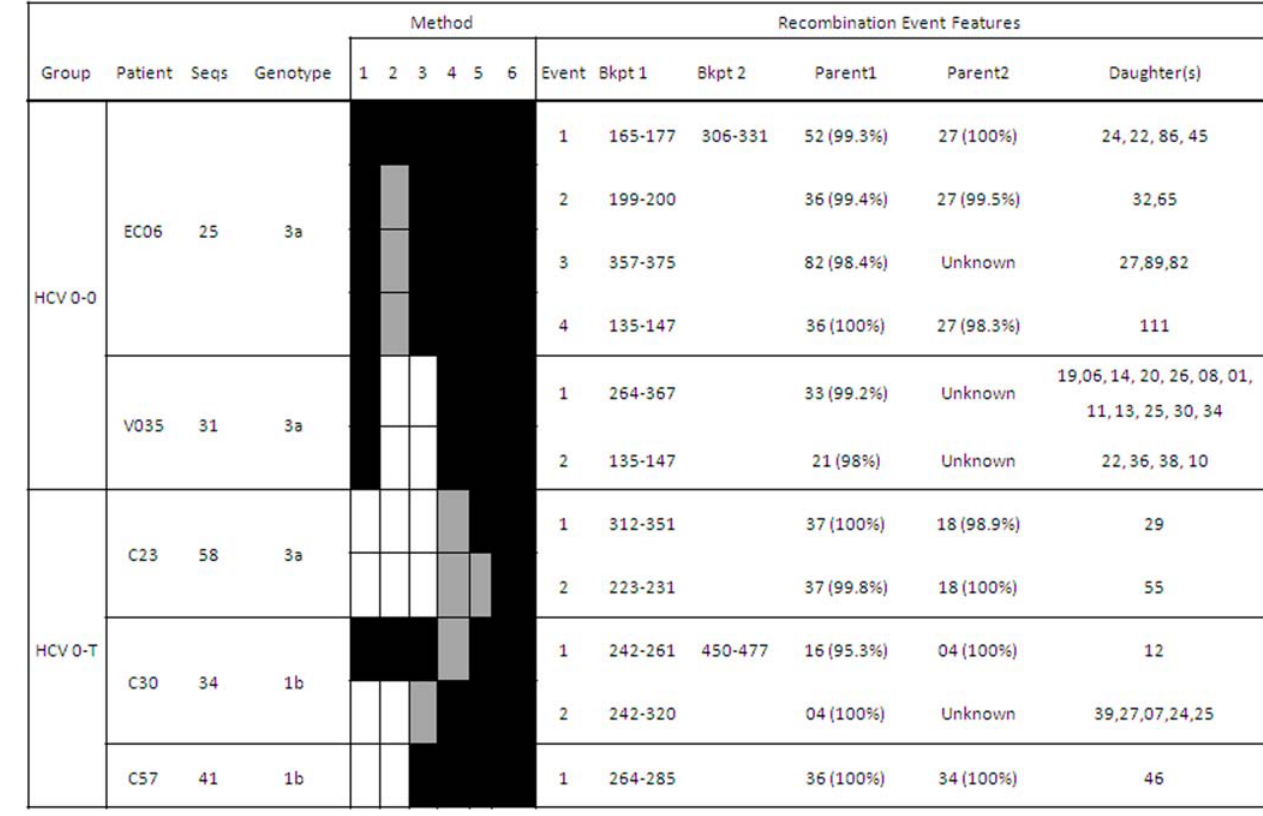
Figure 2. Summary of positive recombination results in the E1-E2 region (HCV-HIV coinfected patients). See further details in legend to Figure 1.